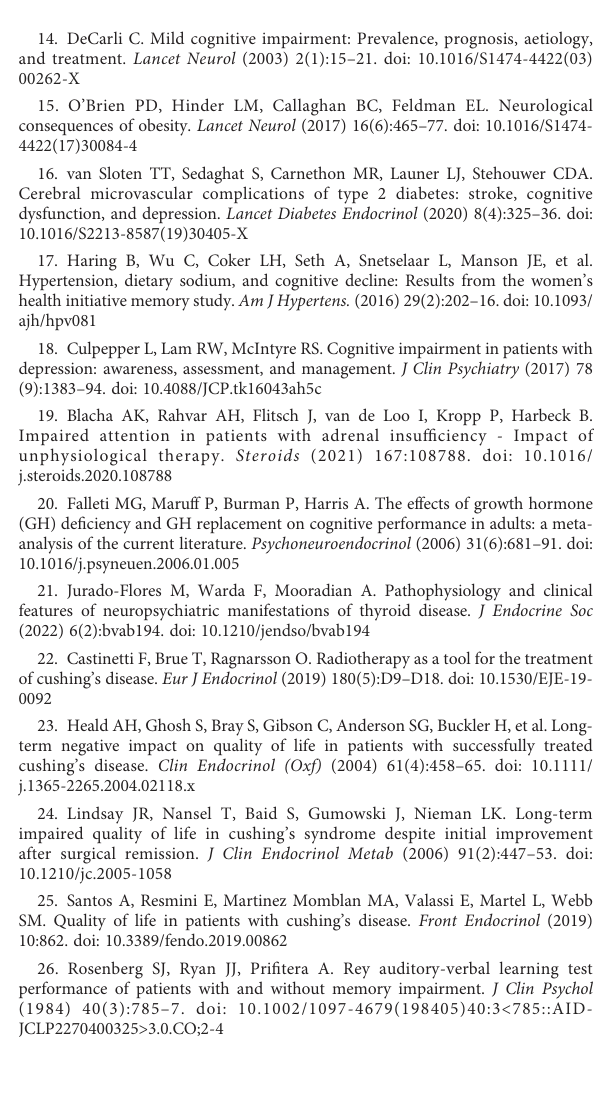
SUPPLEMENTAL TABLE 1 Z-scores of each SF36 subscale in controls and patients with Cushing ’ s disease in remission Z-scores of log data were computed for each participant taking into account the mean and SD of log SF36 measures. A negative z-score indicates that the population has lower quality of life than the corresponding normative